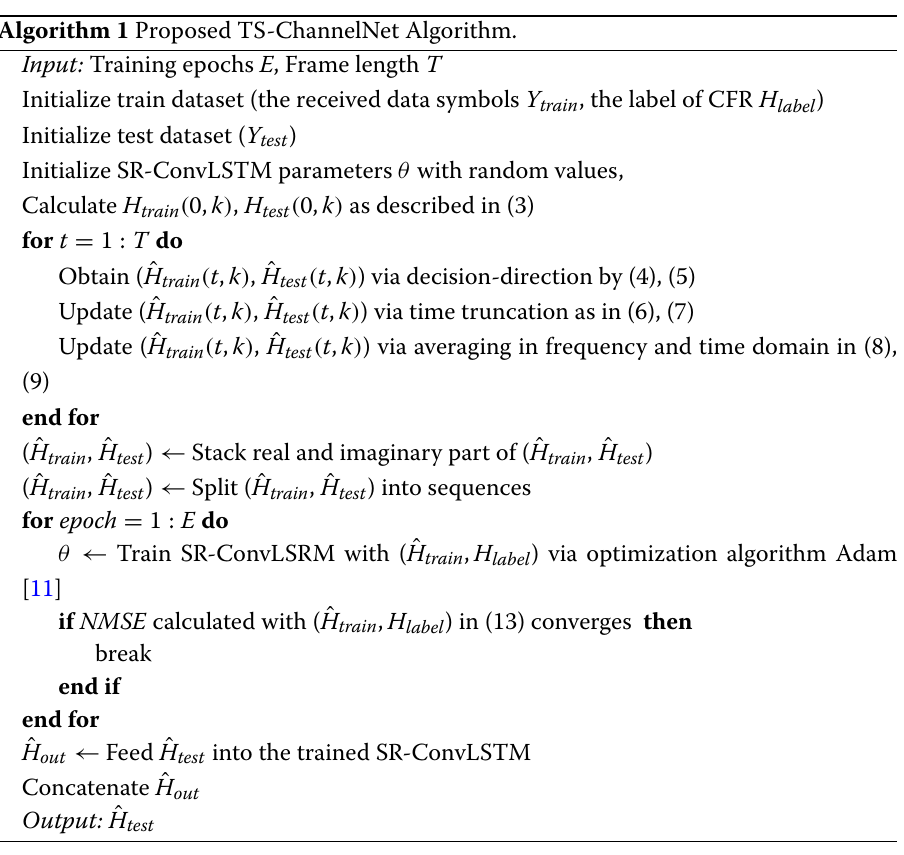
Algorithm 1 Proposed TS-ChannelNet Algorithm.